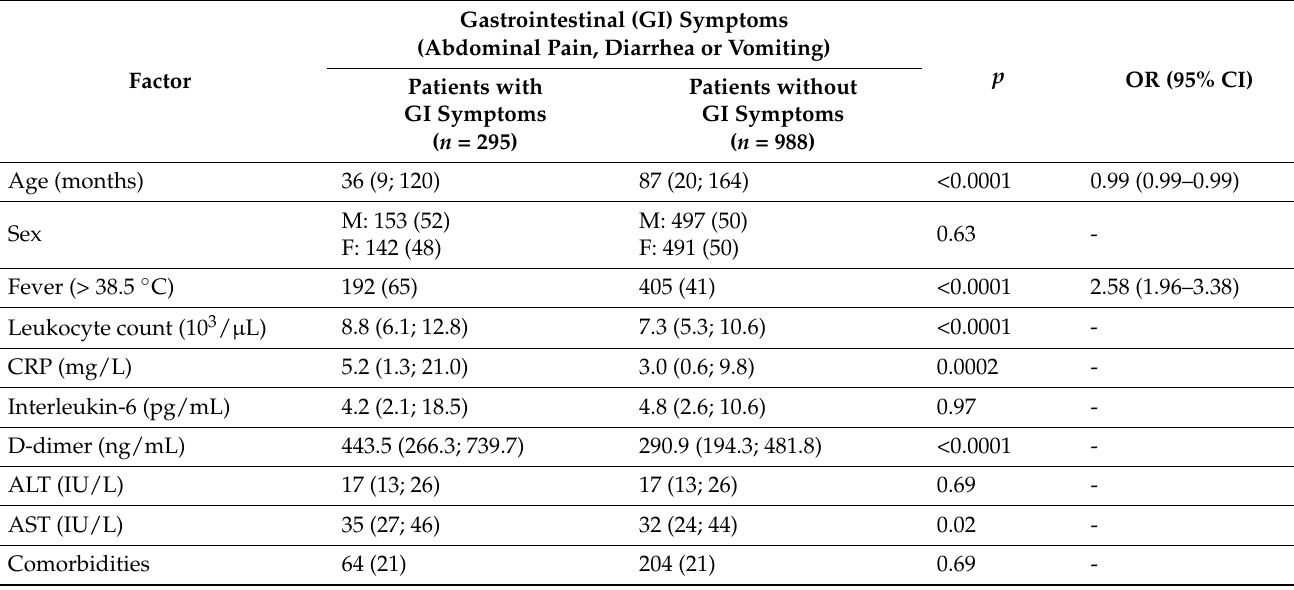
Table 3. Clinical factors associated with gastrointestinal symptoms in the course of COVID-19.